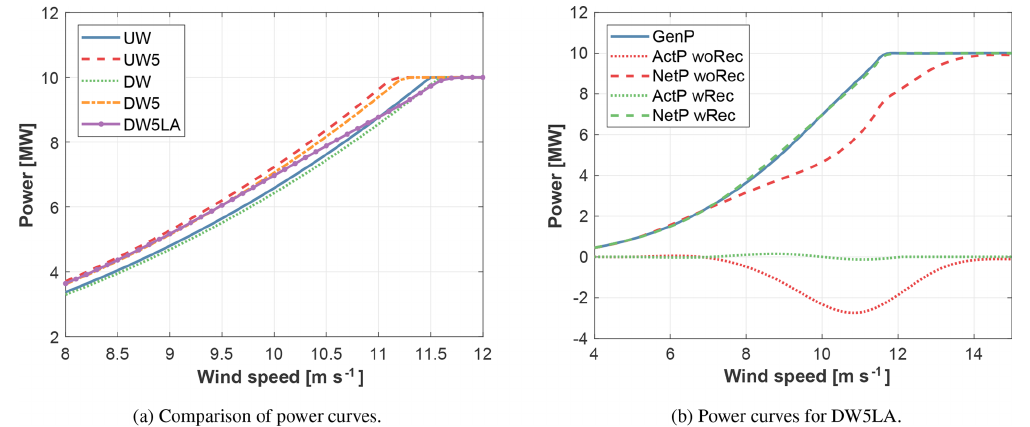
Figure 5. Power generation for the five designs (a) and power consumption of the three coning actuators with and without recovery system (wRec and woRec, respectively). The efficiency of the recovery system is assumed to be equal to